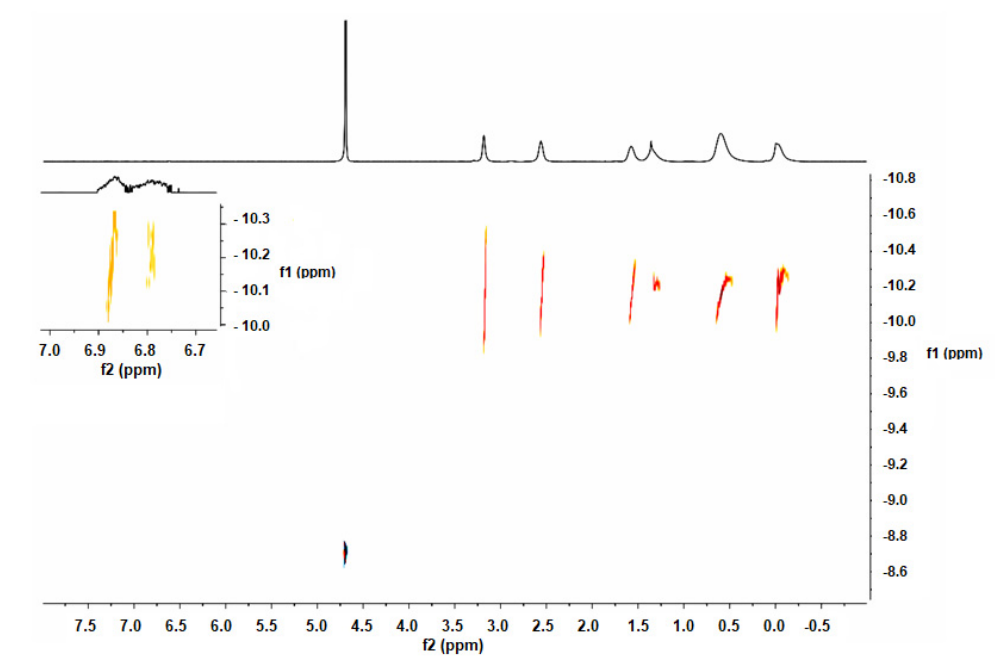
Figure 7. DOSY- 1 H-NMR of G 3 Si(SC 2 H 4 NH FITC)(SCH 2 CO 2 Na) 31 (IV) in D 2 O.